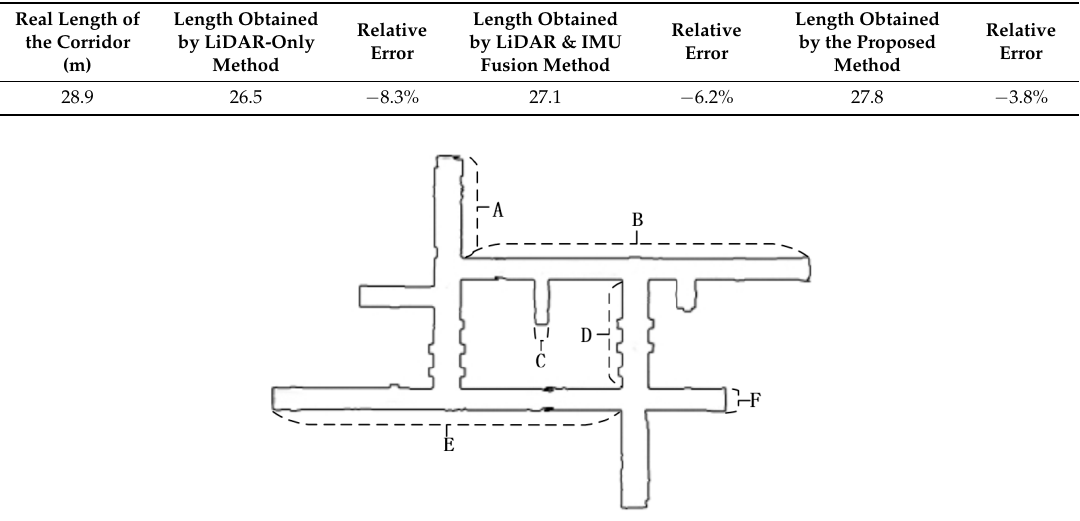
Table 1. Error Comparison in Open Loop.